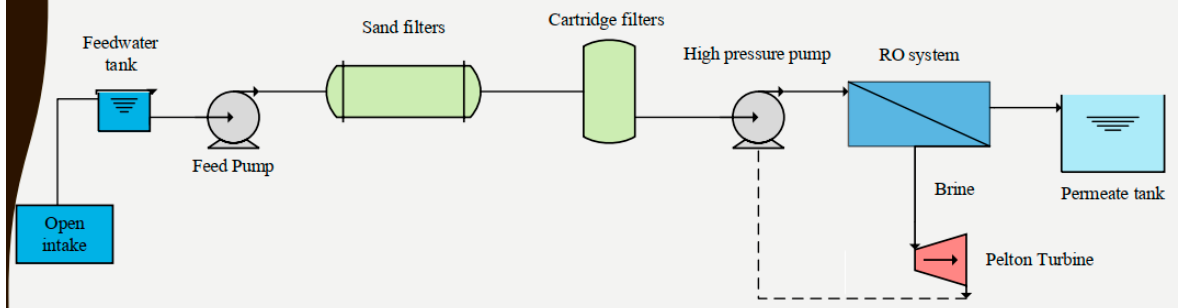
Figure 1. Desalination and plant diagram.